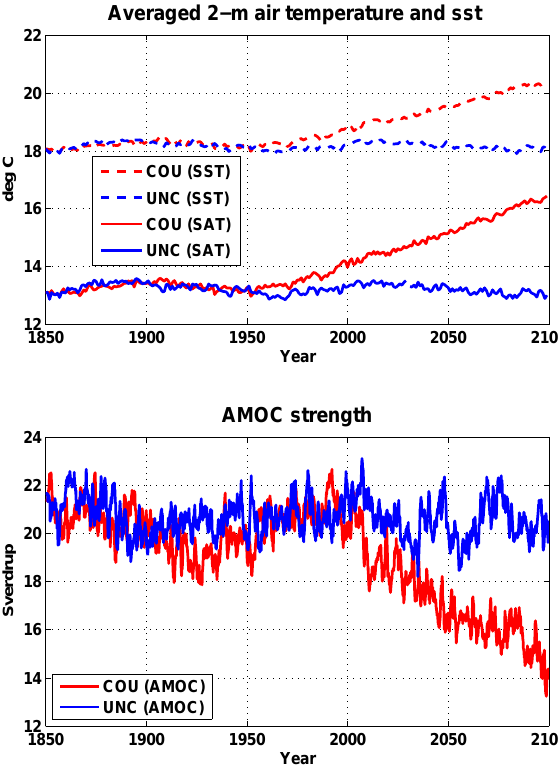
Fig. 4. Time-series of global mean (top) 2-m surface temperature and sea surface temperature and (bottom) strength of the Atlantic Meridional Overturning Circulation as projected by the BCM-C model for both the COU and UNC simulations. There are gener- ally no significant trend changes in the UNC simulation because the changes in atmospheric CO 2 concentration here have no radiative